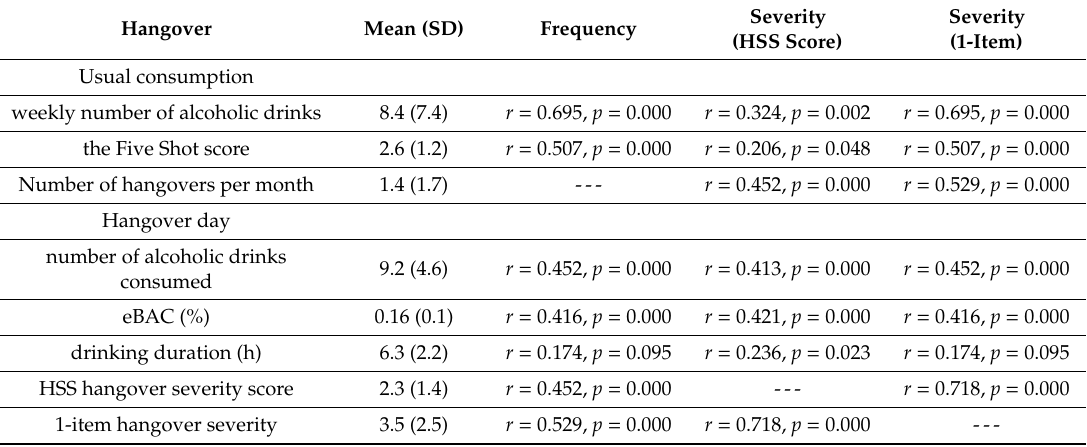
Table 3. Association between drinking variables and severity and frequency of